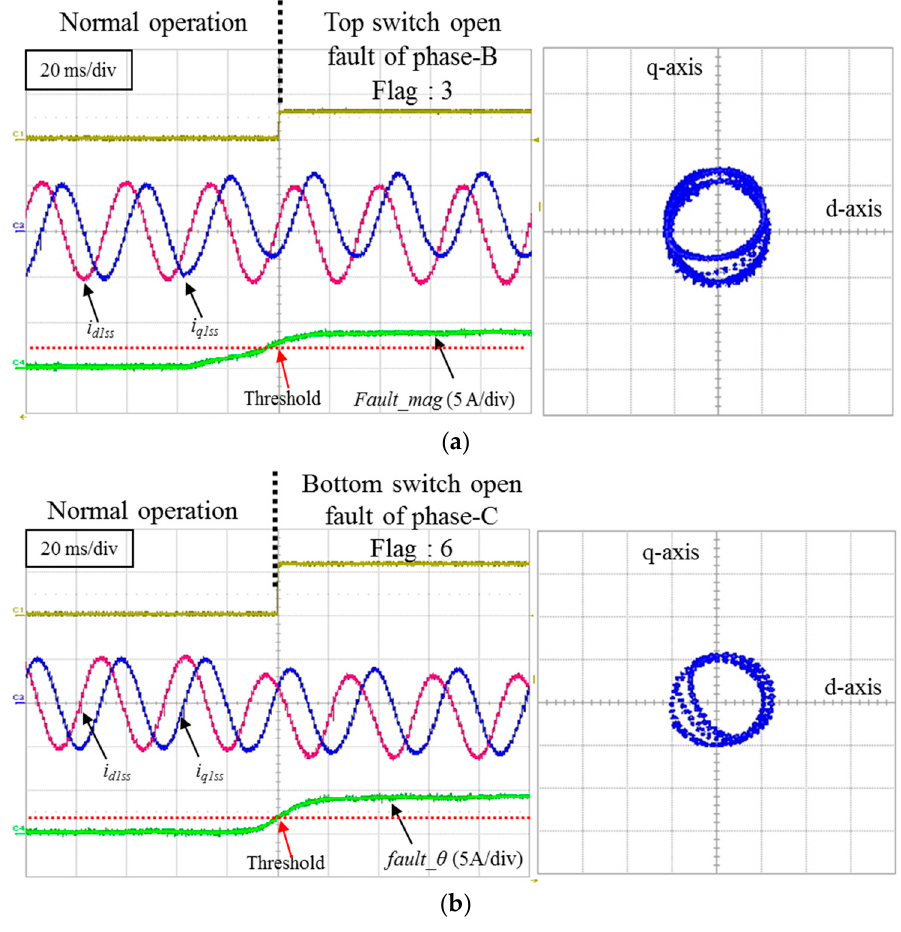
Figure 8. Experimental result of fault detection method about fault_mag : ( a ) Top switch of phase B; ( b ) Bottom switch of phase C.